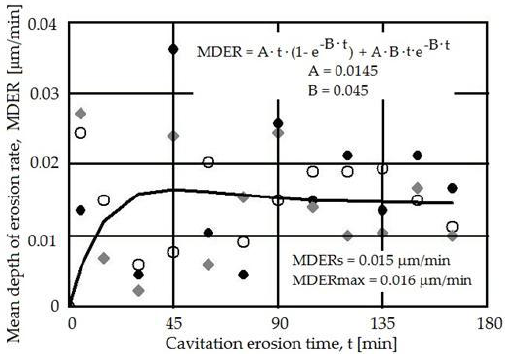
Figure 11. Comparative image of cavitation erosion resistance (reflected by the MDE vs. cavitation erosion time), indicating the improvement as a result of the alumina coating. The 2200 and 2600 W denote the parameters used for laser re-melting of the surface layer, following the Al 2 O 3 ·30(Ni 20 Al) plasma spraying. AMPCO 45 is the base metal shown for comparison purposes.